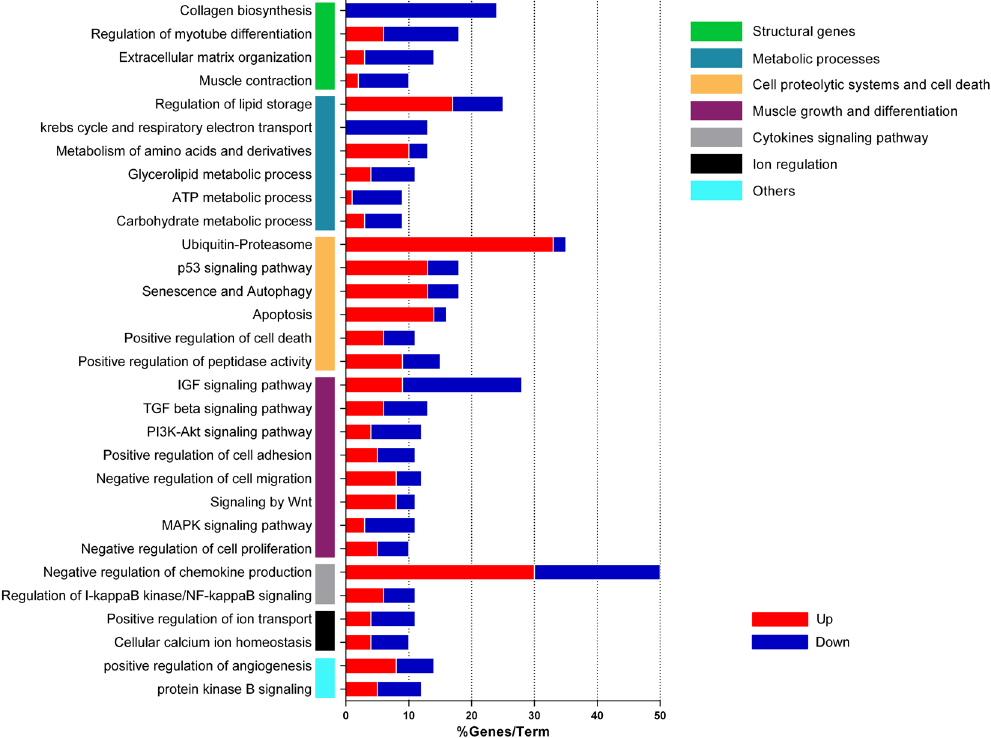
Figure 2. Gene-term enrichment analysis of differentially expressed genes in soleus muscle of cardiac cachexia rats to identify top canonical pathways. Each vertical colored bars (y-axis) represent a major module; horizontal bars represent the percentage of genes presented in the data set compared to the total number of genes in each pathway. Fraction of DE genes in each pathway (up/down, red/blue; respectively) are shown in x-axis. Additional information in Supplementary Table S2.